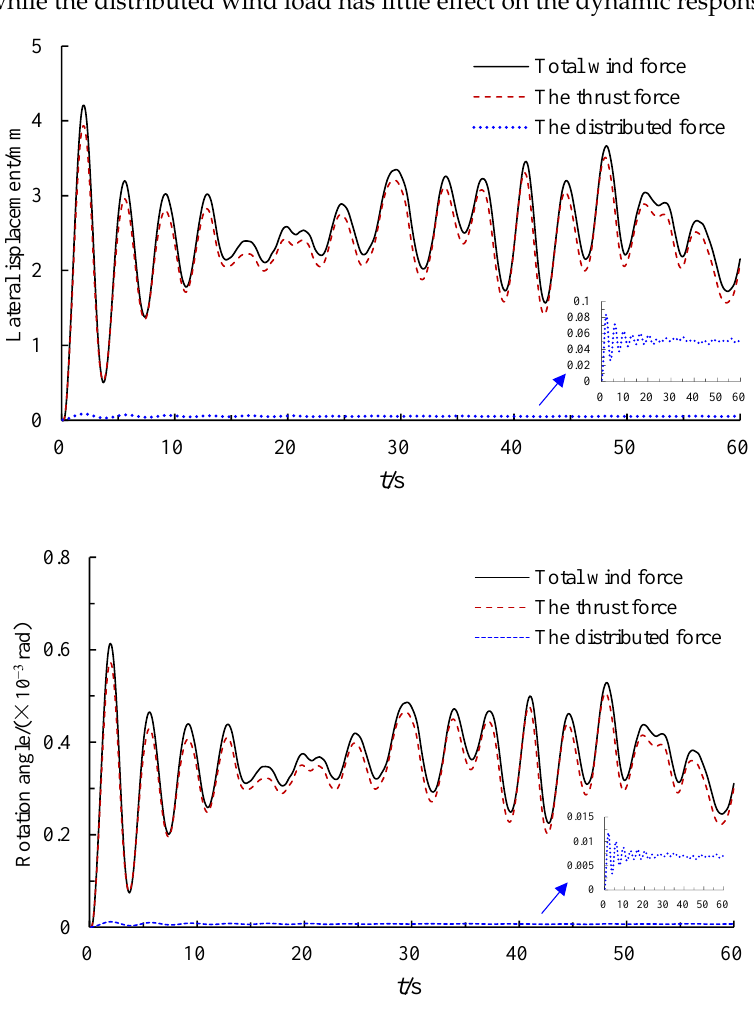
Figure 15. Dynamic response of the GBF when V m ( 10, t ) = 10